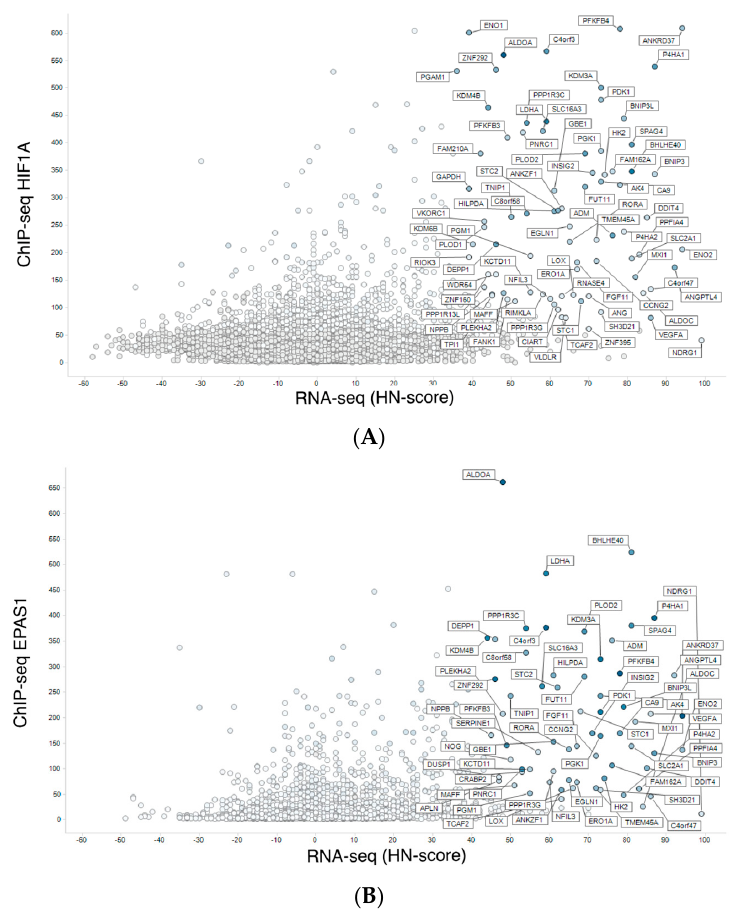
Figure3. Integrationofmeta-analyzedChIP-seqpeakvaluestohypoxictranscriptomes. ( A )Meta-analyzed hypoxic transcriptomes (RNA-seq) vs. average of HIF1A ChIP-seq peak values. ( B ) RNA-seq and EPAS1